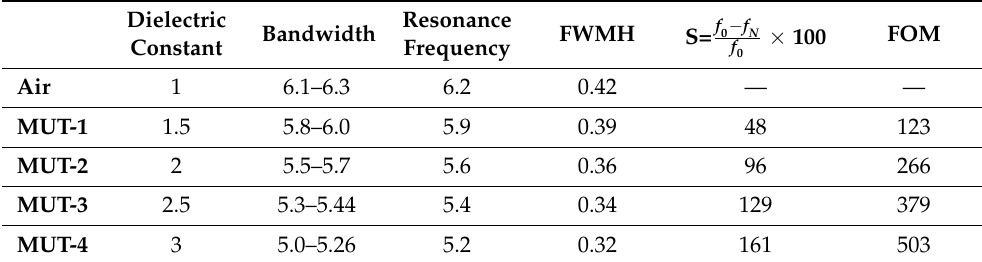
Figure 14. ( a ) 3D view of proposed sensor with MUT and ( b ) corresponding result of reflection coefficient for different MUT. Table 2. Sensing properties for different dielectric constant.